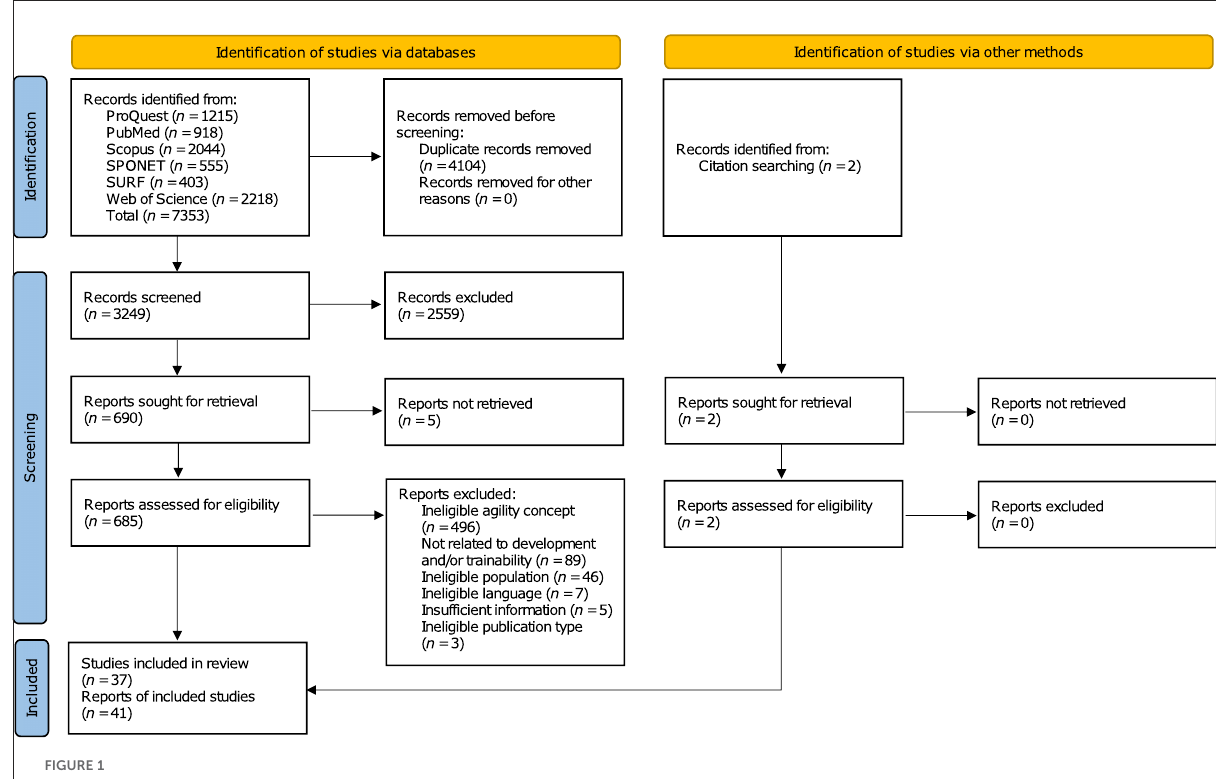
FIGURE1 PRISMA 2020 flow diagram of the search and selection process